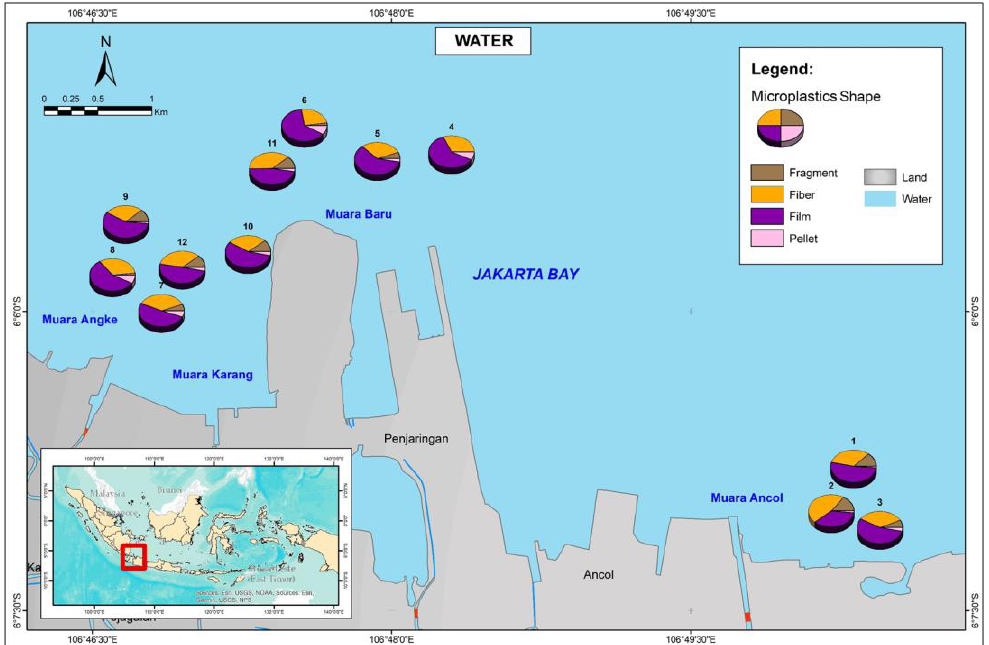
Fig. 4: Distribution and abundance (particles/L) of microplastic in Jakarta Bay surface water